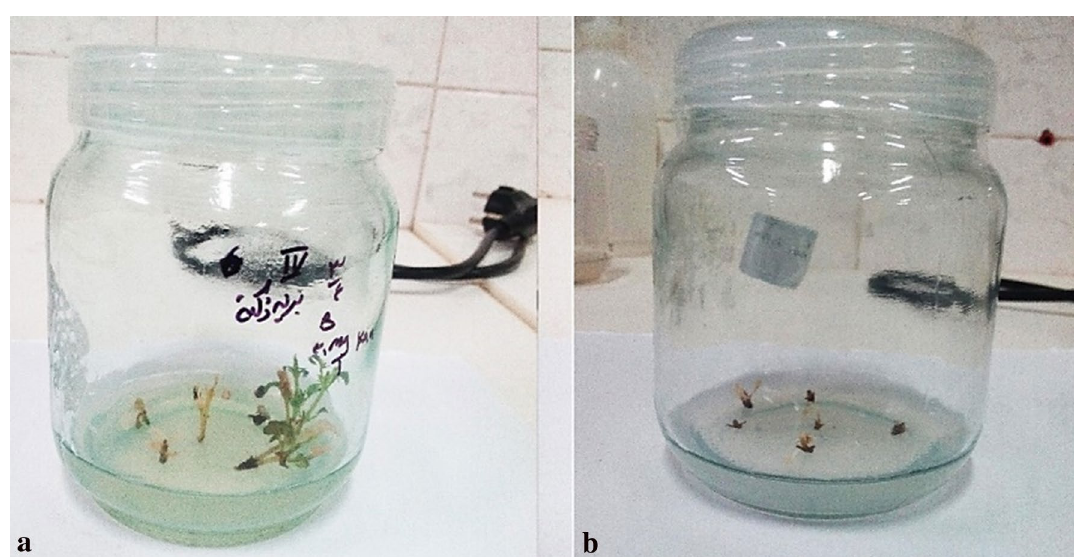
Figure 5. Explants on regeneration medium containing 30 mg l −1 and 60 mg l −1 kanamycin. ( a ) Explants on a medium containing 30 mg l −1 kanamycin after 3 weeks; ( b ) explants on a medium containing 60 mg l −1 kanamycin after 3